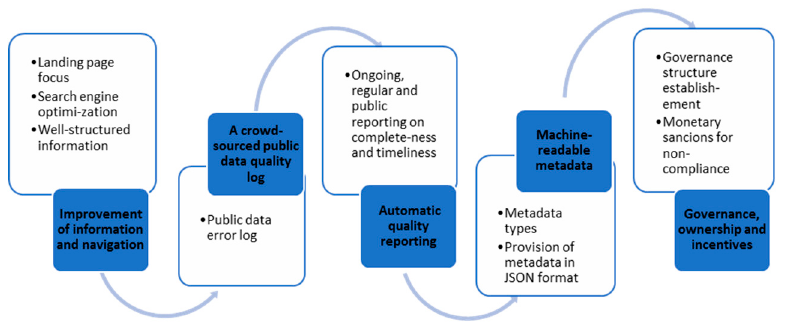
Figure 11. Suggestions for improvement of the European Network of Transmission System Operators for Electricity (ENTSO-E) Transparency Platform [19].